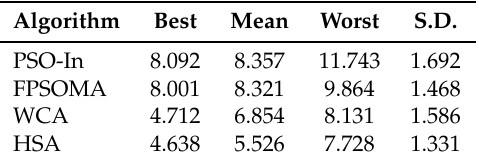
Table 5. Results of the optimization from 20 trials of Problem (32): Particle Swarm Optimization